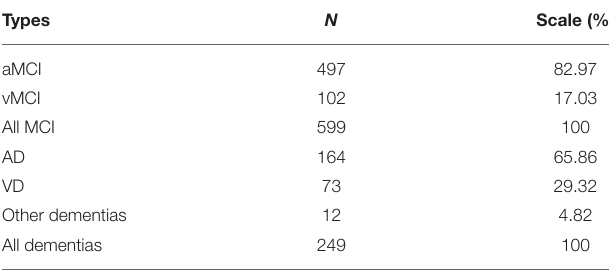
TABLE 1 | All types of dementia and